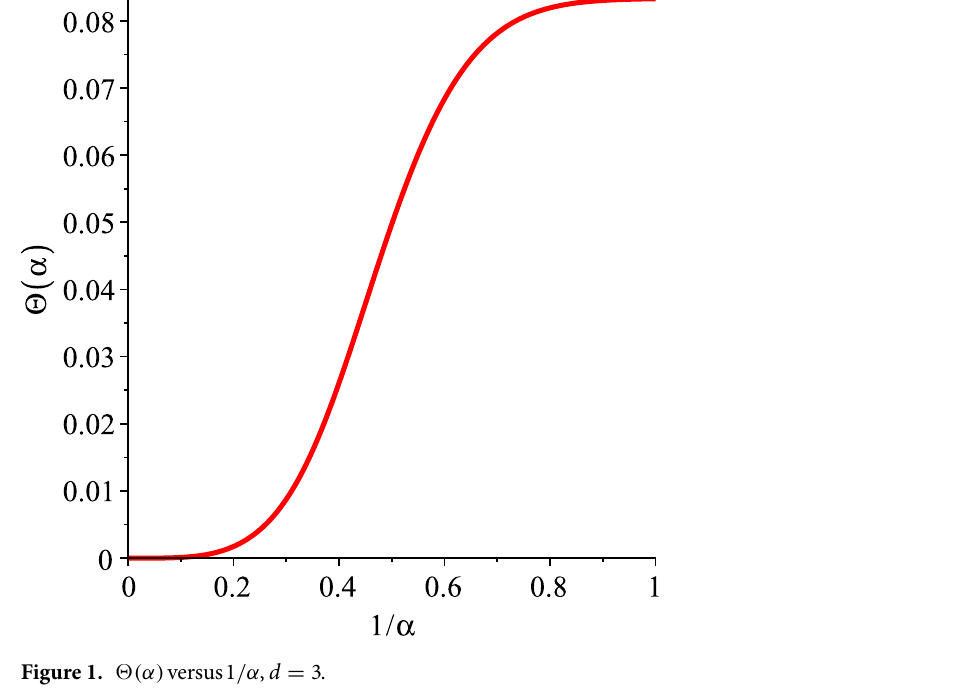
Figure 1. �(α) versus 1 /α , d = 3